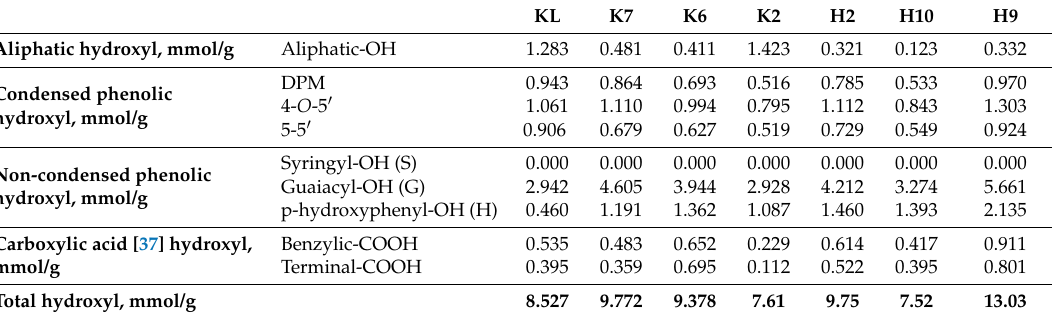
Table 6. 31 P NMR analysis of hydroxyl groups in depolymerized kraft